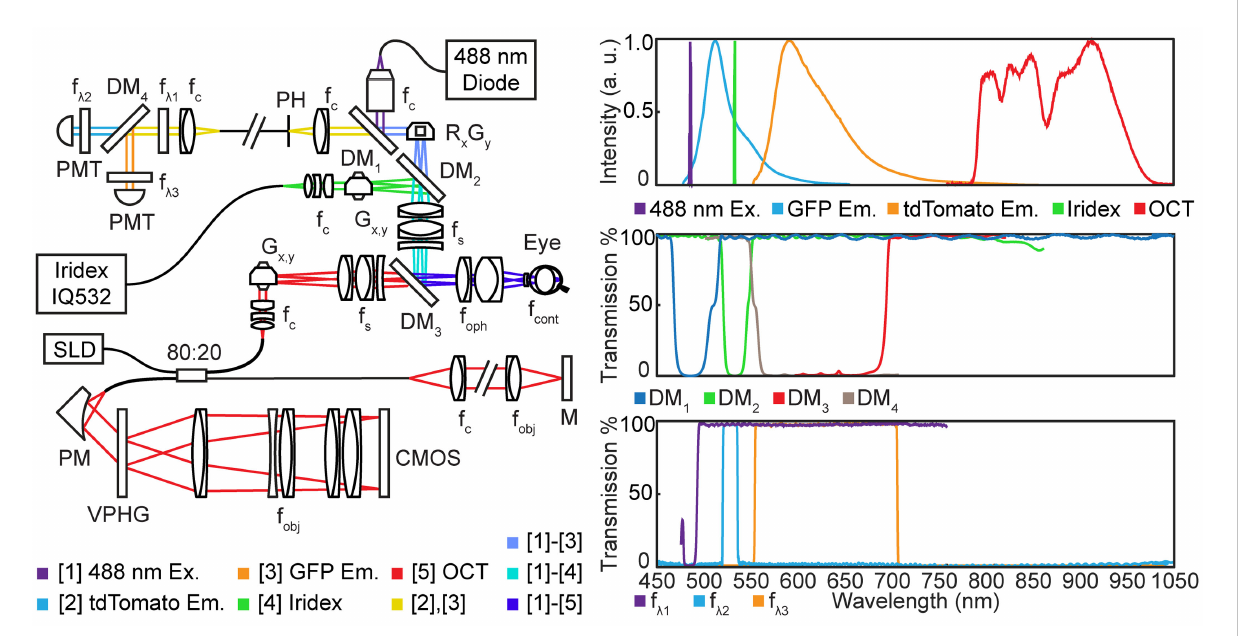
FIGURE 1 System schematic showing optical components and relays in MURIN. Inset includes spectra for all light sources and fl uorophores and transmission spectral for all dichroic mirrors and fi lters. CMOS, CMOS detector; DM, dichroic mirrors; f l : spectral fi lters; f, collimating, objective, and scan lens; G, galvanometers; M, mirror; PM, parabolic mirror; PMT, photomultiplier tube; R, resonant scanner; SLD, super luminescent diode; VPHG, volume phase holographic